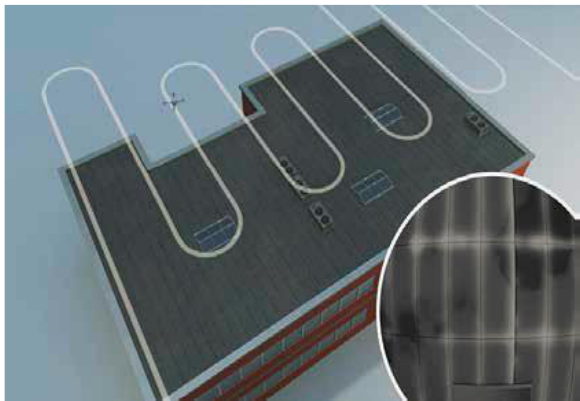
Figure 1: Conceptual illustration of UAV-based thermal infrared inspection of roof insulation (Tremco 2014a) However, the orthomosaic image generation brings in the autogain control (AGC) problem of thermal cameras. For thermal imagers, heat energy emitted by objects is a particular scene is converted into a series of electrical signals, which are processed and automatically gain corrected for store and display. AGC image based on the relative thermal emission of objects in the scene, which means the grayscales of objects with the same apparent temperature are scaled differently in different scenes.